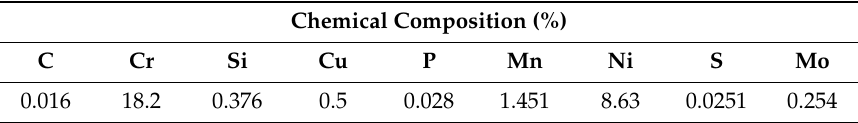
Table 1. Chemical composition of 304L stainless